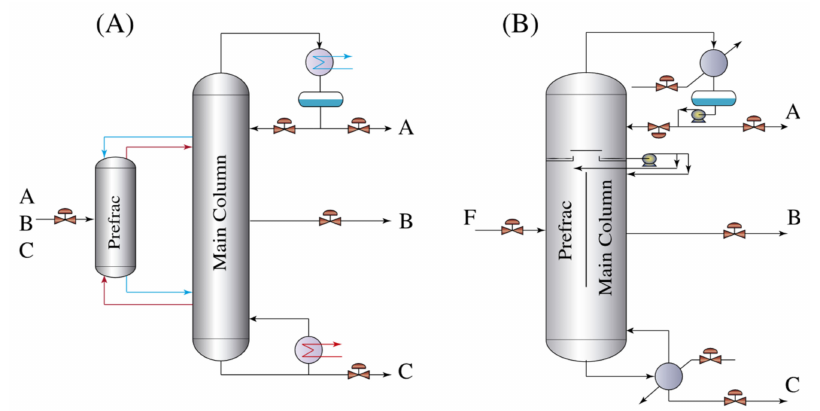
Figure 2. ( A ) Petlyuk Column. ( B ) Practical implementation as a dividing-wall